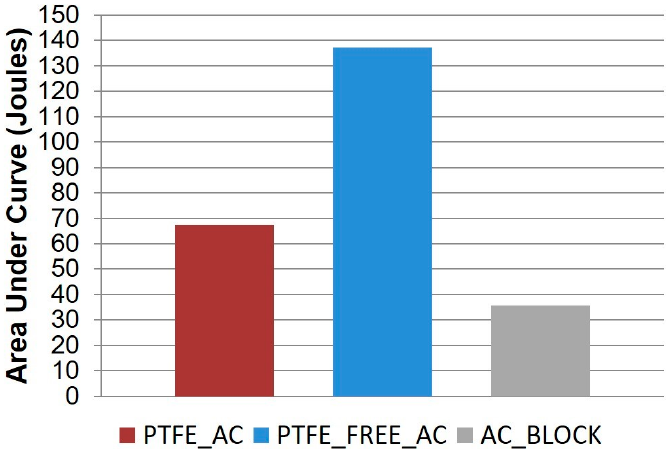
Figure 2. Overall calculated area under the curve, presented in Joules, based on the temporal power output data.